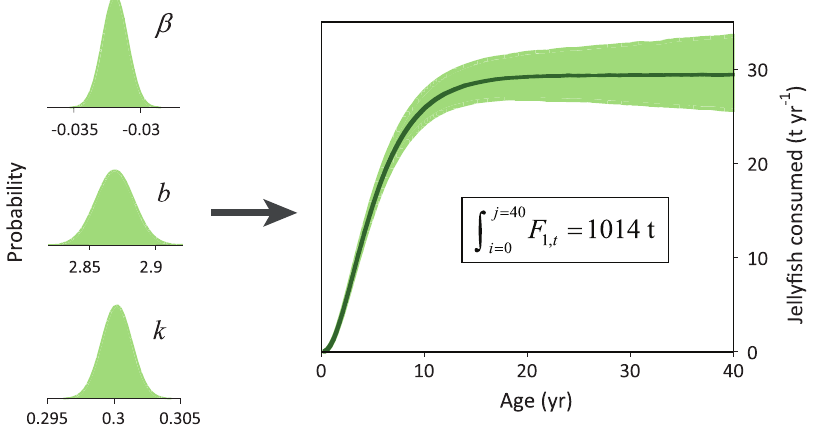
Figure 2. Annual leatherback dietary consumption rates. Three left panels show the empirically estimated probability density functions for the variables b (food conversion constant), b (scaling exponent), and k (growth parameter) which populate the consumption model (right). The solid dark green line on the right plot is the model average, the green shaded area is the 95% CI, obtained from Monte Carlo simulations of the input variables. Integration of the model average suggests that a leatherback will consume 1014 t of jellyfish (range 924–1112) from hatching through adulthood (age of 40 yrs).